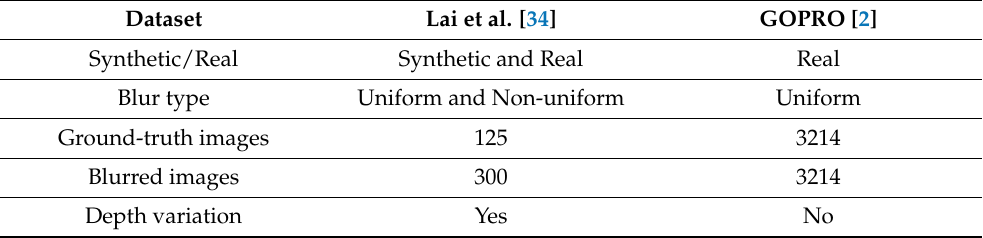
Table 1. Basic dataset characteristics of GOPRO [2] and Lai et al. [34].